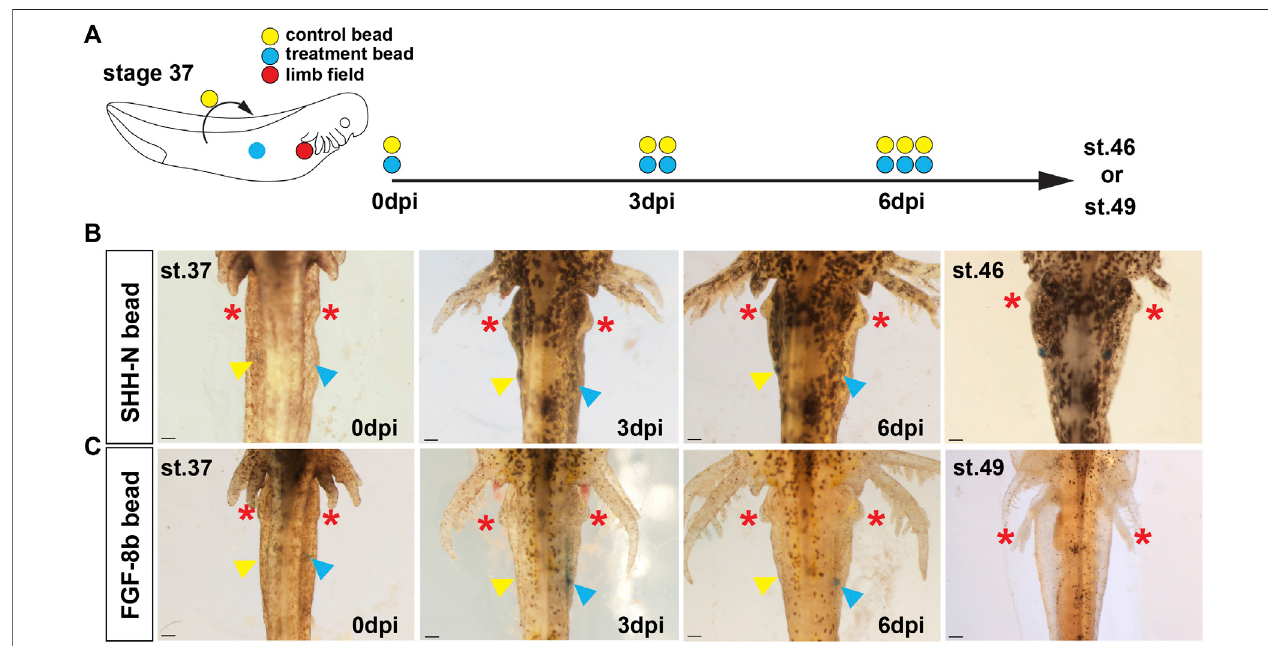
FIGURE 3 | Stage 37 embryonic fl ank tissue in axolotls is refractive to exogenous SHH-N or FGF-8b proteins and does not form ectopic limb outgrowths. (A) Schematic representation of the embryonic bead implantation experiment using stage 37 axolotl embryos. Colored circles represent the right limb fi eld (red), relative implantation site of protein-soaked beads (blue) or 1× PBS/0.1% BSA soaked beads (yellow). (B,C) SHH-N and FGF8 protein-soaked beads were grafted into the right fl anklateraltothesomites(bluearrow),and1×PBS/0.1%BSAbeadswereimplantedintosymmetricalpositionsintheleft fl ank(yellowarrow).Threedayspost fi rst beadimplantation(dpi),asecondpairofbeadswereimplantedintothesamelocationasthe fi rstbeads,and,consequently,athirdpairwereimplantedat6 dpi.Evidence ofectopiclimbdevelopmentwastrackeduntilstage46(forSHH-Nbead)orstage49(forFGF-8bbeads),and,ineithertreatmentcondition,wedidnotobserveevidence of limb outgrowth. Red asterisks mark emergence and growth of the normal forelimbs. Scale bar = 1 mm.